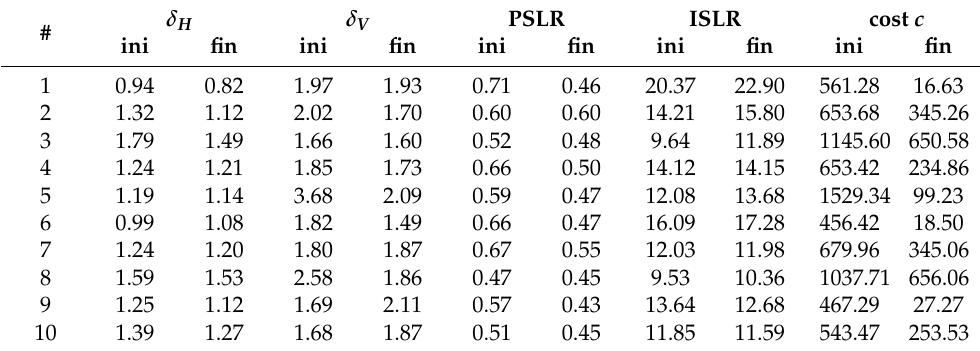
Table 3. Trajectory generation result parameters for ten different start